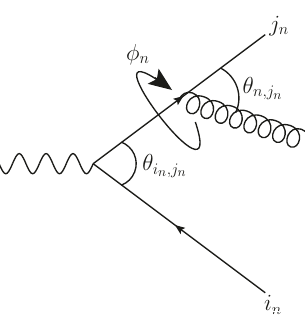
Figure 2 . The angles used to derive angular ordering by azimuthal averaging. (cid:30) n is the azimuth that is averaged over. In some equations two azimuths are present, in these situations we give (cid:30) n a second index, e.g. (cid:30) n;j . Angular ordering corresponds to (cid:18) i n